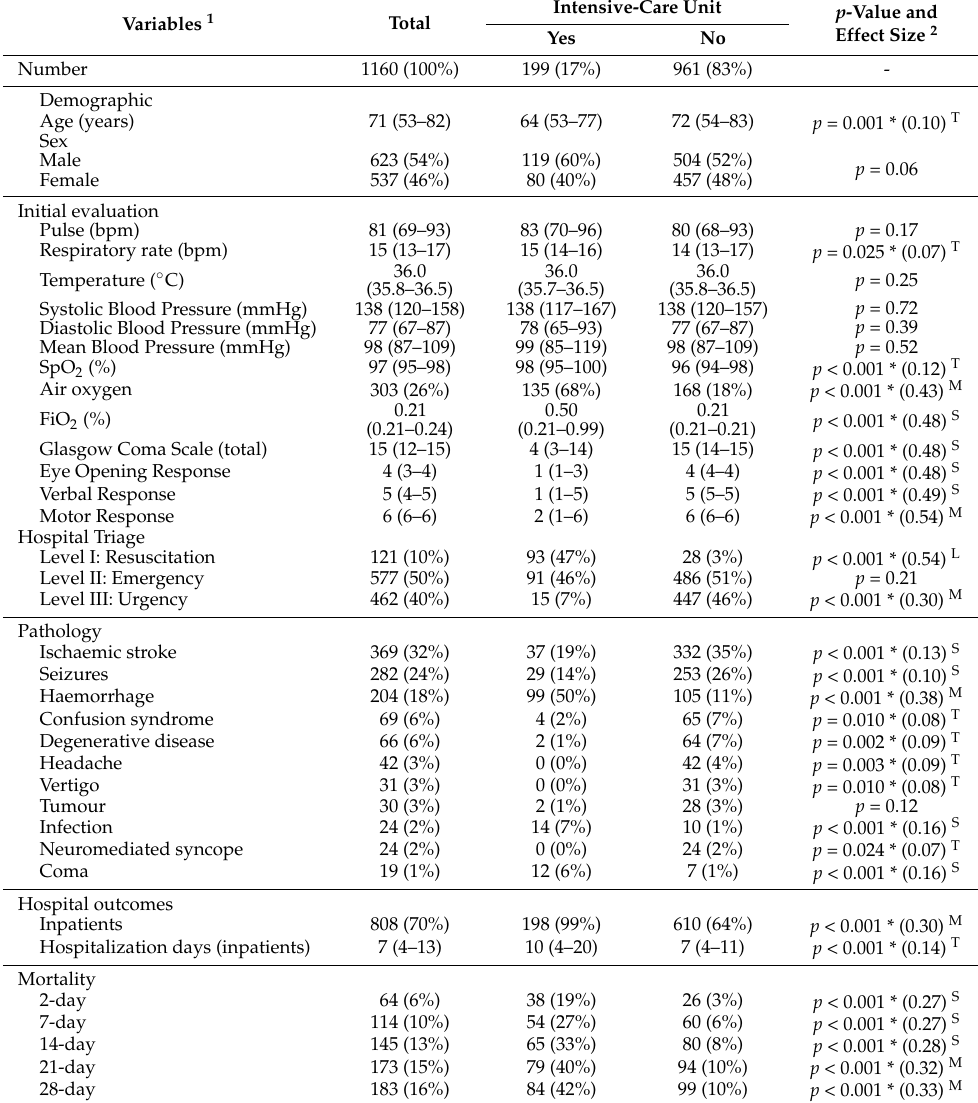
Table 1. Comparison of patient variables recorded in the emergency department according to the patients’ intensive